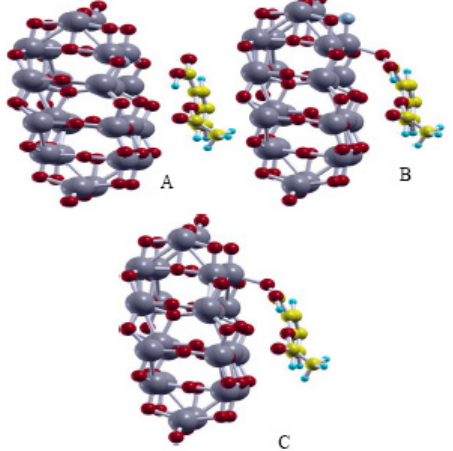
Fig. 6. Optimized TiO2-Aspirin complexes with perpendicular adsorption configurations.